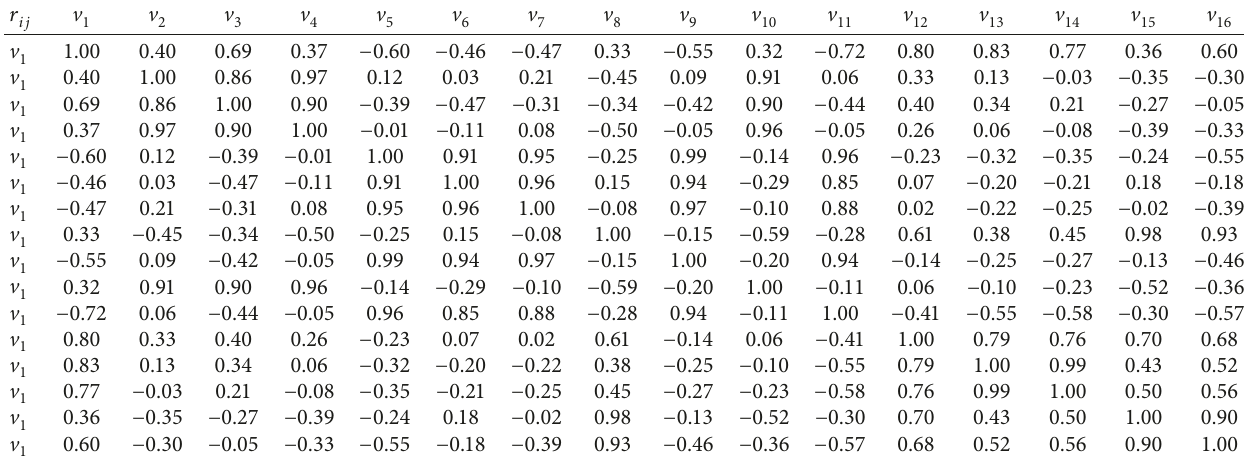
Table 2: Correlation coefficient matrix.Table 2 is reproduced from Mikoni [10] (under the Creative Commons Attribution License/public